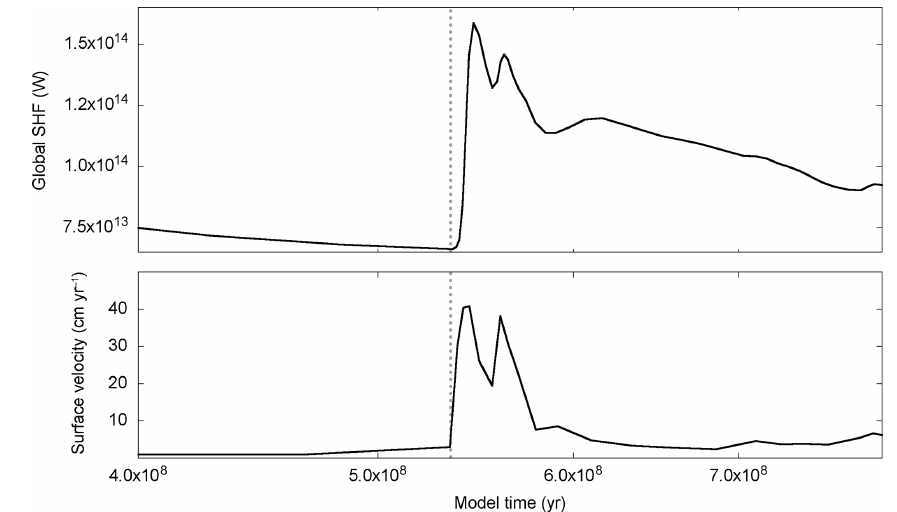
Figure 4. Plot of global surface heat flux and horizontal velocity for Case 2. Both curves are plotted with data points at the same time intervals; grey dotted line demonstrates the timing offset between velocity and heat flux